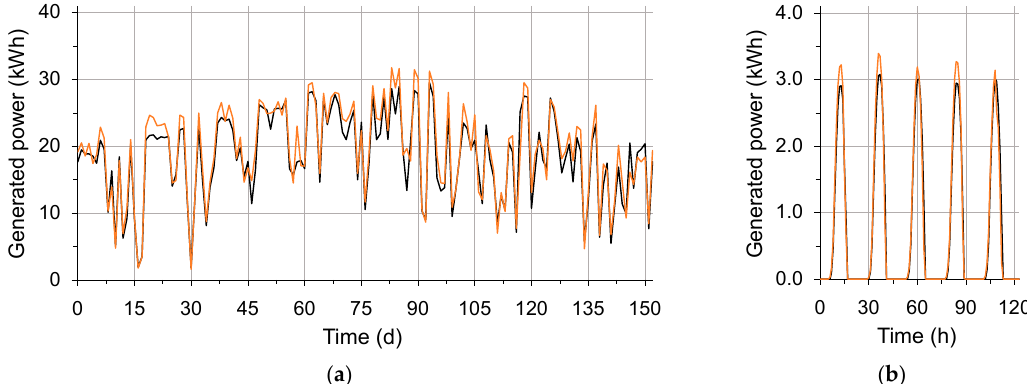
Figure 3. Simulated (black line) and measured (orange line) power generation from a roof-top system with an installed capacity of 4.51 kW ( a ) over a period of five months with a daily resolution and ( b ) over the first five days of this period with an hourly resolution.